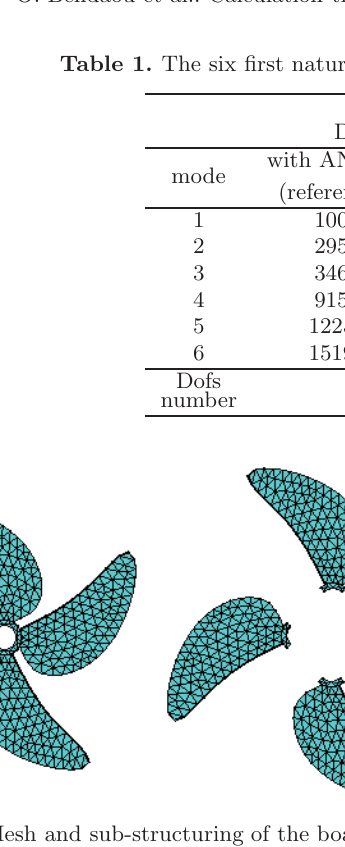
Fig. 2. Mesh and sub-structuring of the boat propeller.